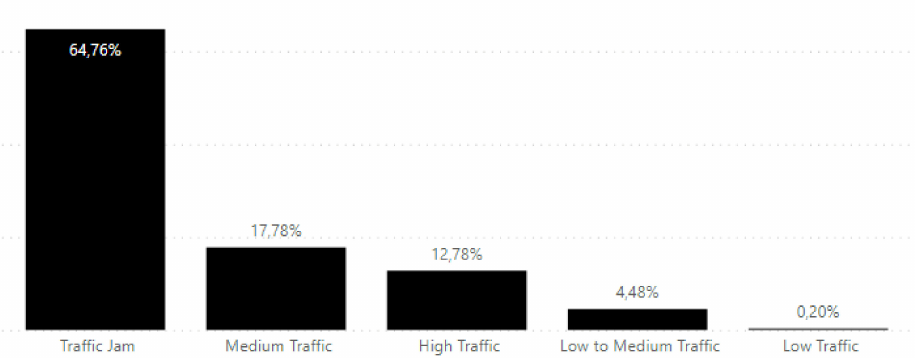
Figure 3. Traffic distribution by severity level in Lisbon in